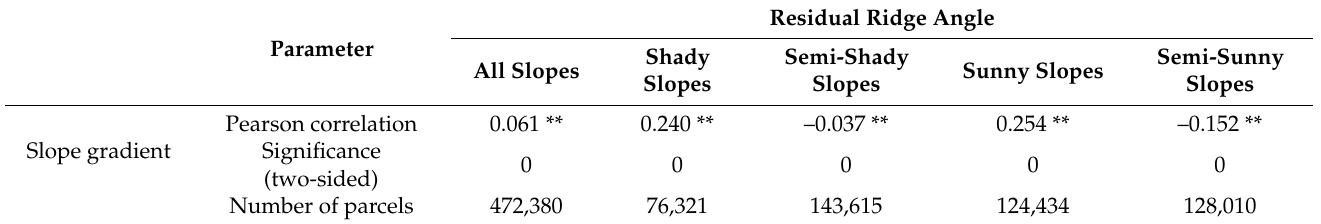
Table 2. Correlation between slope gradient and ridge orientation with respect to different slope